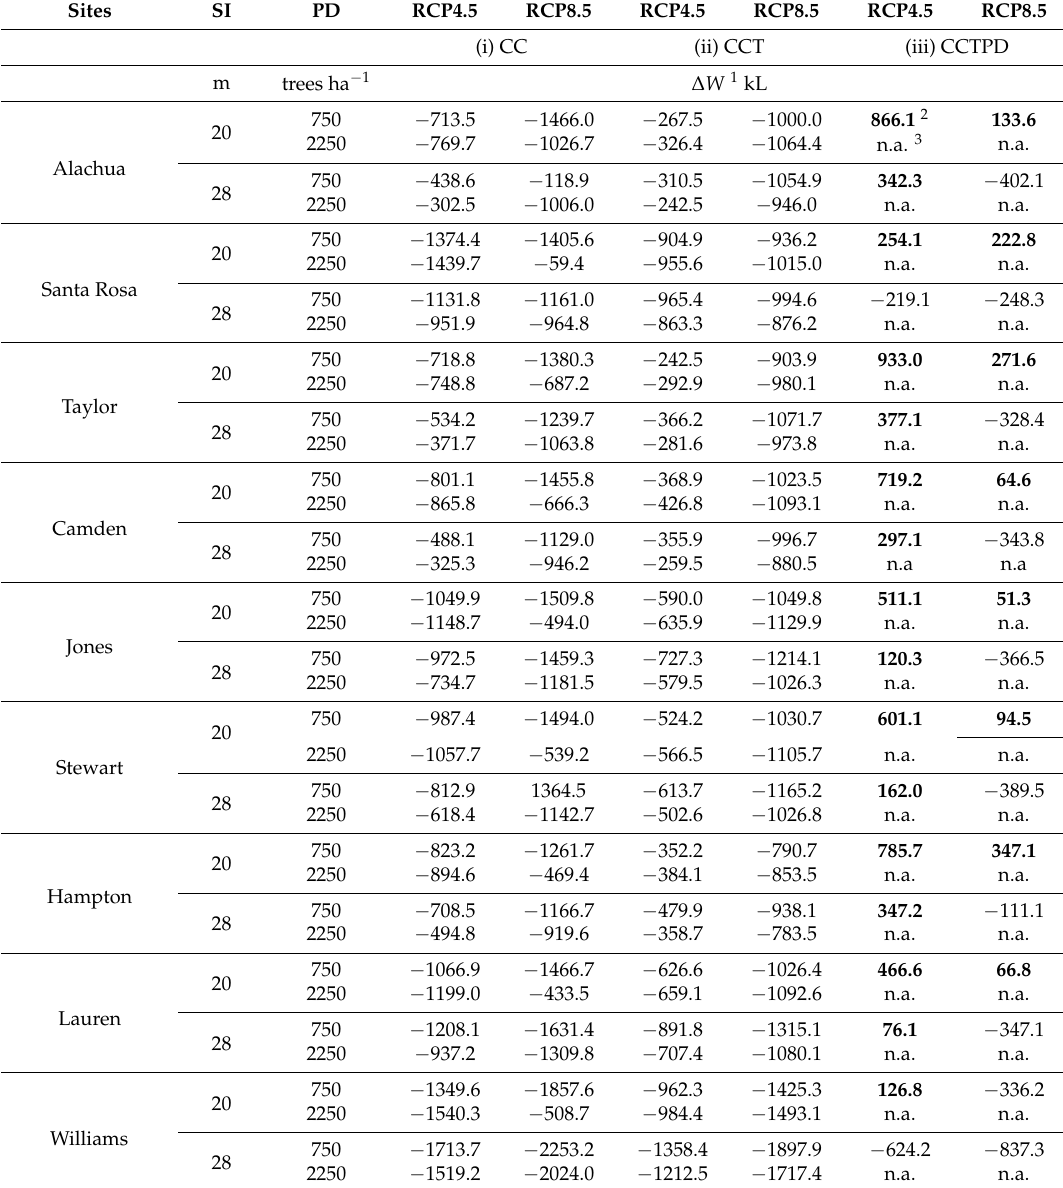
Table 3. Average fluctuations in water yield for each site and forest management for the climatic